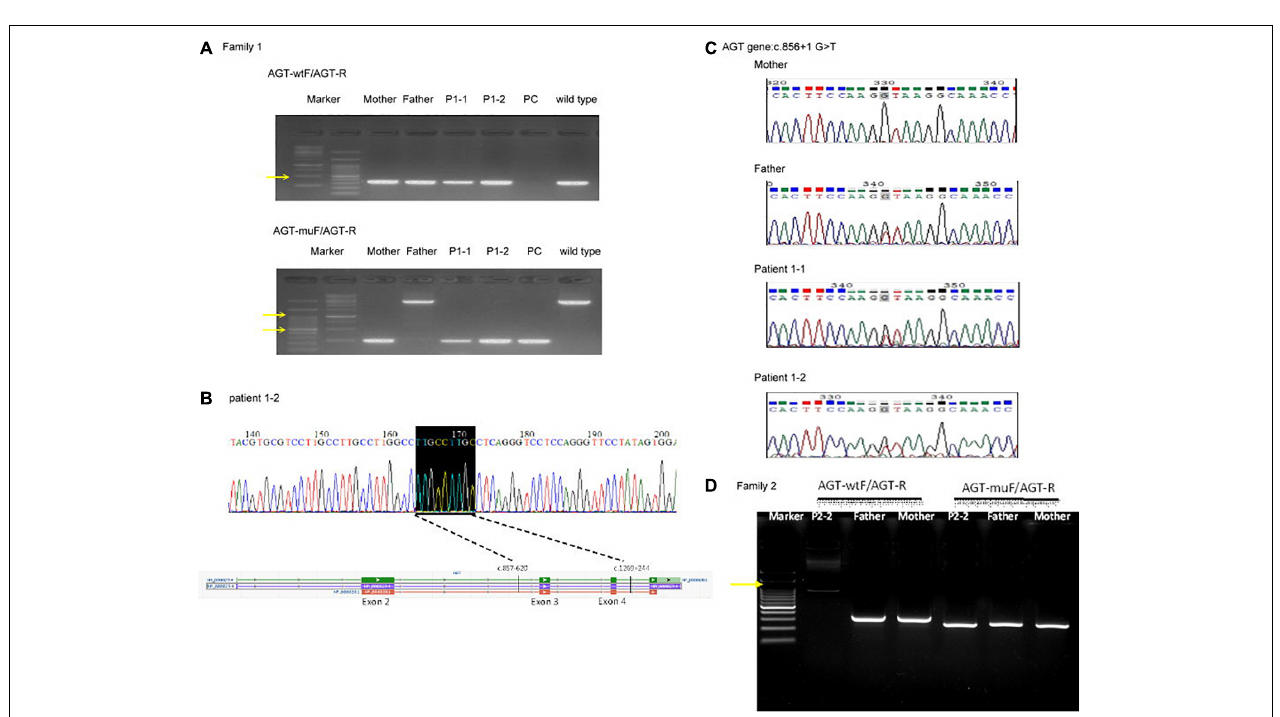
FIGURE 3 | mRNA splicing analysis of the AGT gene from renal tissue of the terminated fetus showed that the fetus has (A) exon 2 skipping and (B) exon 3–4 skipping.